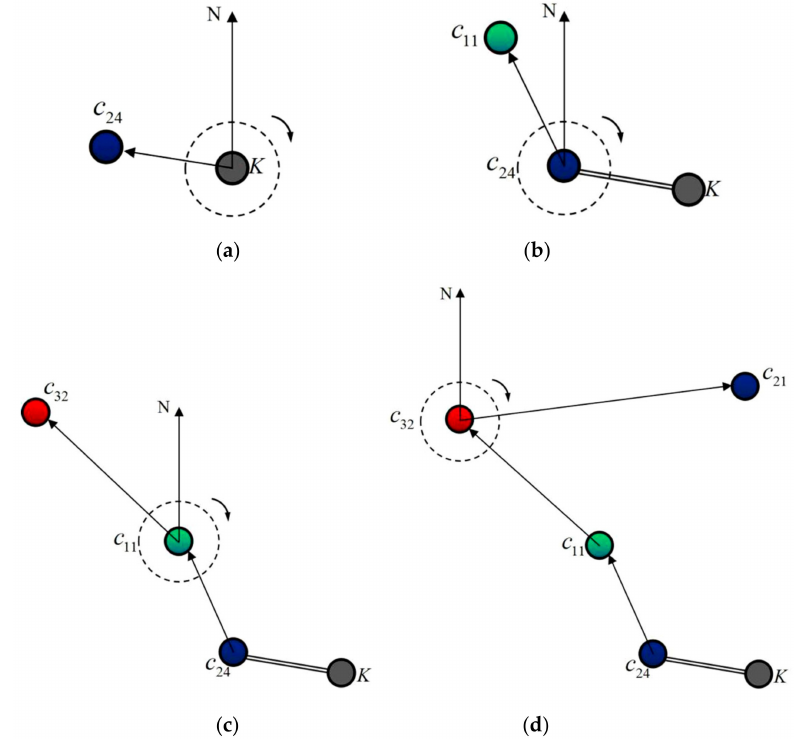
Figure 6. The process of generating an optimal tourist site structure tree. ( a ) Starting from the central point K and searching the result of seed tourist site c 24 . ( b ) Starting from the central point c 24 and searching seed tourist site c 11 . ( c ) Starting from the central point c 11 and searching seed tourist site c 32 . ( d ) Starting from the central point c 32 and searching seed tourist site c 21 .